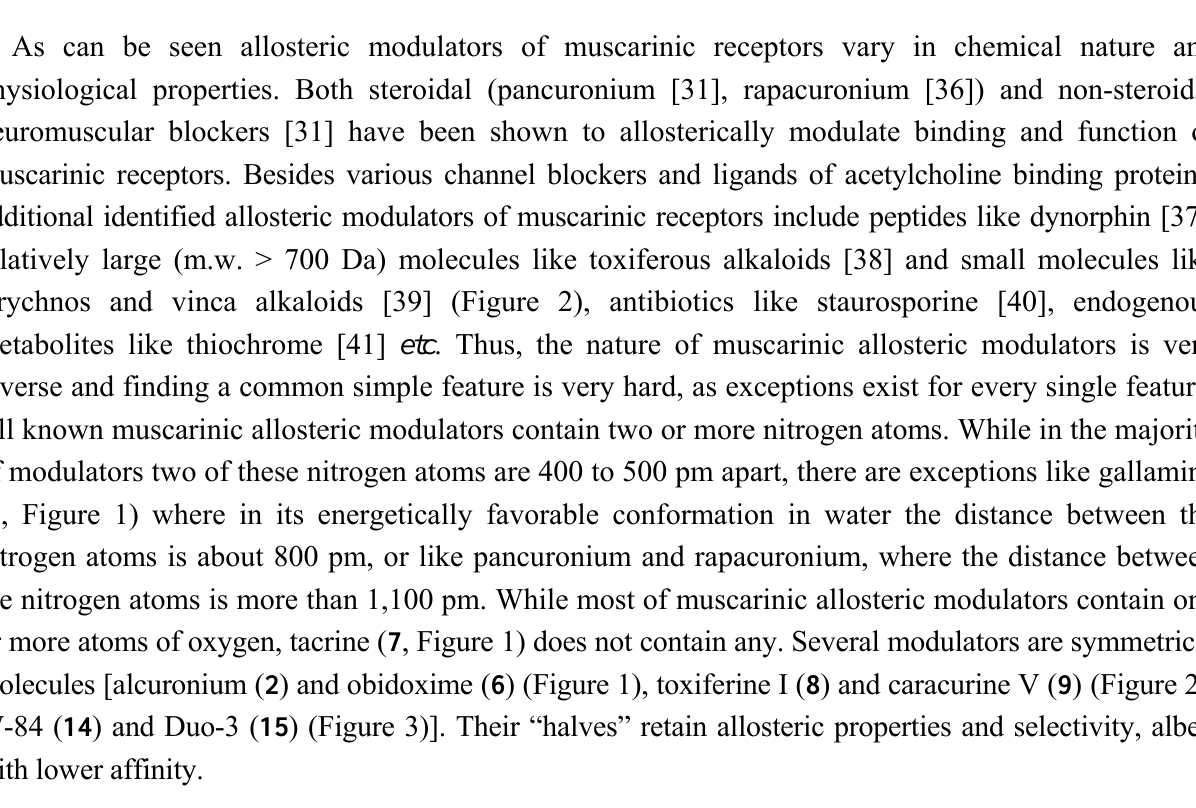
Figure 2. Structures of toxiferous, strychnos and vinca